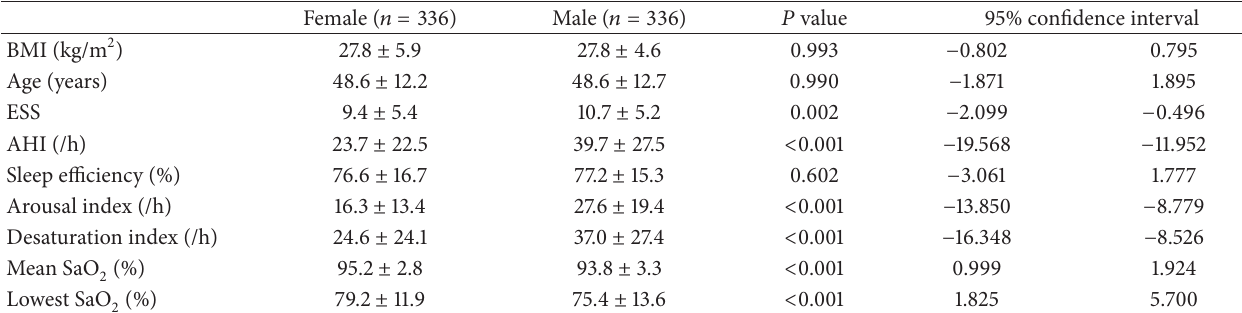
Table 2: Characteristics and polysomnographic variables of the male and female patients with obstructive sleep apnea after propensity score matching